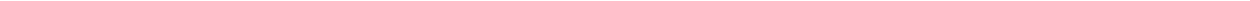
bars: 1mm. ( i ) Measurement of neoepidermal tongues and gaps at wound sites ( n ¼ 5). ( j ) Dual labelling for CD31 (red) and LYVE1 (green) in the wound. Scale bars: 50 m m. ( k ) Quantification of the relative vessel area per 20 (cid:3) field by fluorescence densitometry ( n ¼ 4). ( l ) Quantification of the number of vessel types per 20 (cid:3) field ( n ¼ 4). ( m ) Representative micrograph of a wound section labelled for vWF (red) and displaying spontaneous eGFP fluorescence (green), demonstrating the recruitment of FMCs to wound sites to form a vessel wall. Scale bars: 50 m m. ( n ) Quantification of vWF þ eGFP þ double-positive vessels in 4 (cid:3) field ( n ¼ 4). ( o ) FACS analysis showed that there were significantly larger numbers of eGFP þ CD31 þ cells in the wounds of